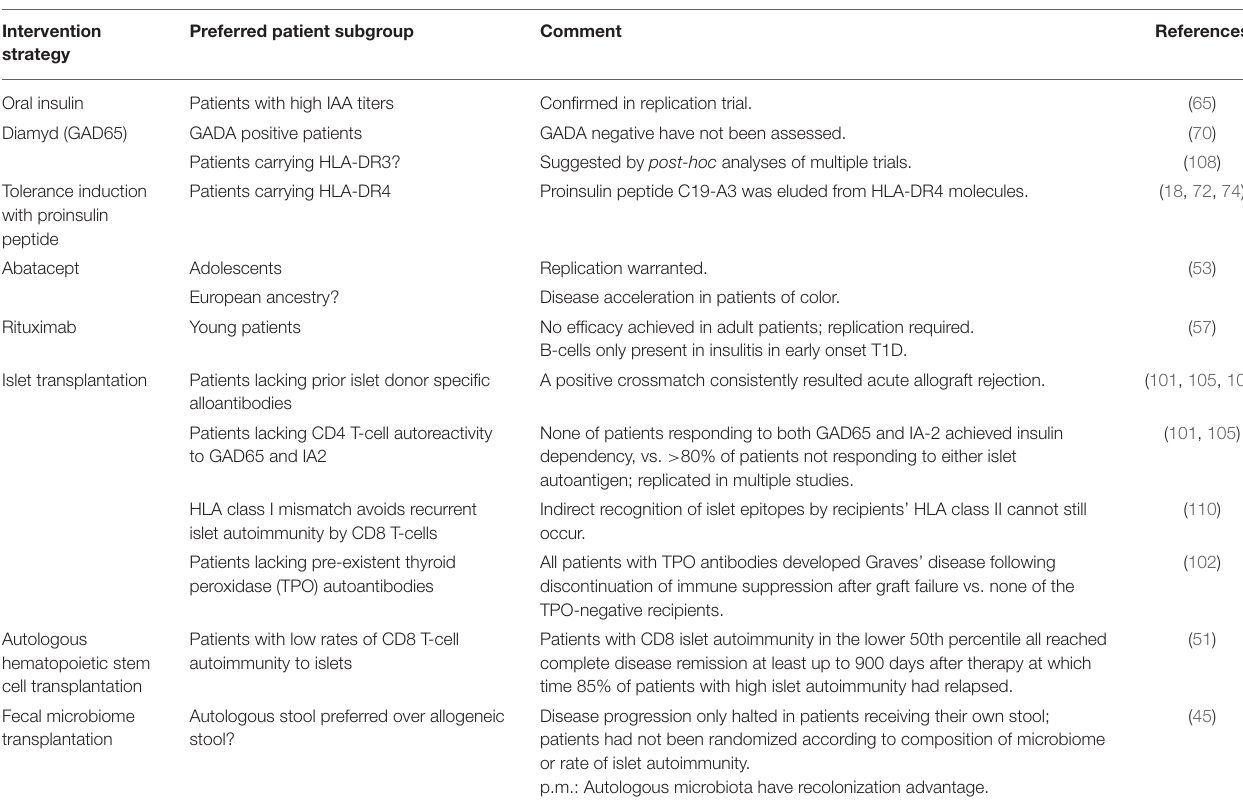
TABLE 2 | Opportunities for precision medicine in type 1